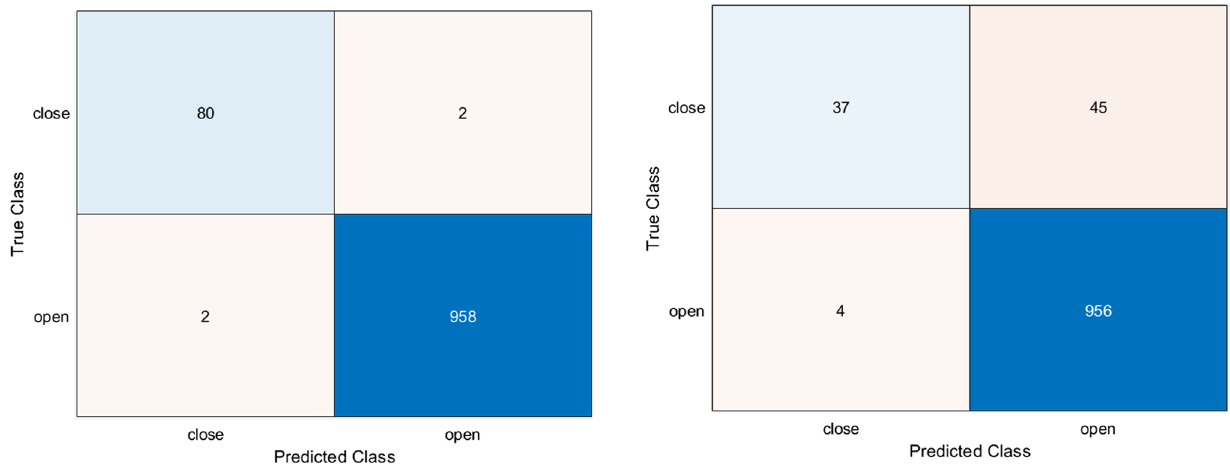
comparison of DCNN (trained ZJU and CEW datasets)